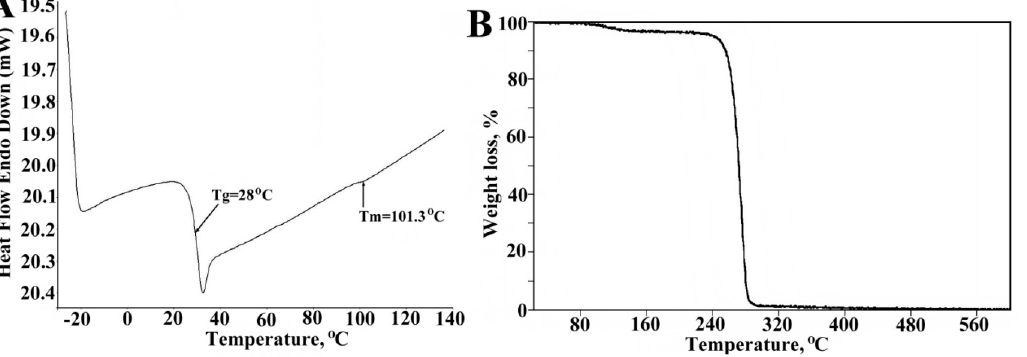
Figure 3. DSC trace of treated ( A ) and TGA trace of untreated ( B ) Th-PDLLA macromonomer. The DSC investigation was performed on two samples; one of them by using the product as resulting after the purification and keeping in desiccator under vacuum, and another one on the sample taken from desiccator after a while and to which a 48 h treatment into the vacuum oven, at room temperature, was applied (denoted as “treated sample”). The T g values obtained for both types of Th-PDLLA samples (26.5 °C for the one and 28 ◦ C for the treated one) are in agreement with the values reported for other PLA end-functionalized compounds with molecular weight in the range of oligomers